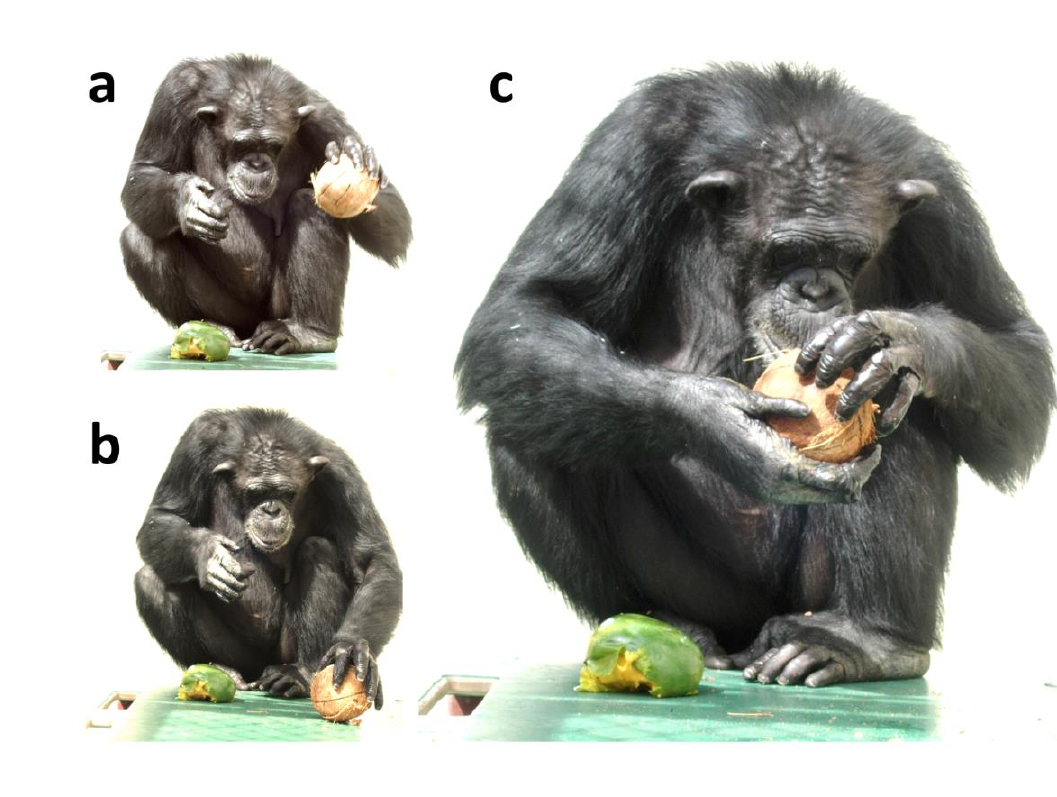
Candy uses a Coconut as a Tool, then Cracks it